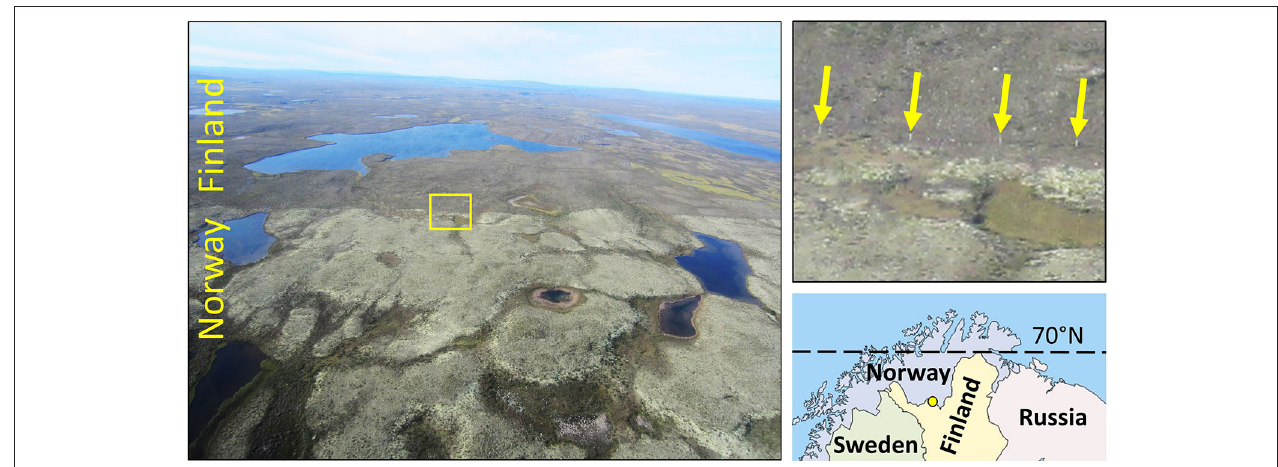
FIGURE 21 | Aerial photograph looking from north to south across the Norway-Finland border on Finnmarksvidda (site indicated by a yellow dot on the location map). The border is evident as a line of change in the color of the ground running horizontally across the middle of the picture. The pale green color of the foreground (Norway) reflects the presence of a continuous mat of terricolous lichens; the brown color in the upper half of the picture (Finland) indicates the absence of lichens, the brown color being due to tundra plants (creeping shrubs, graminoids and mosses). Four posts of the fence erected to prevent the movement of reindeer either way across the border are visible (yellow arrows) in an insert corresponding to the yellow square in the main picture. The lichen mats on the Finnish side of the border have been destroyed by reindeer trampling them in summer when they are dry and therefore brittle. This in turn is a result of the animals having been prevented by the fence from leaving the area and moving to their traditional summer pastures near the coast of Norway. Photograph (21st August 2013): Bernt Johansen.